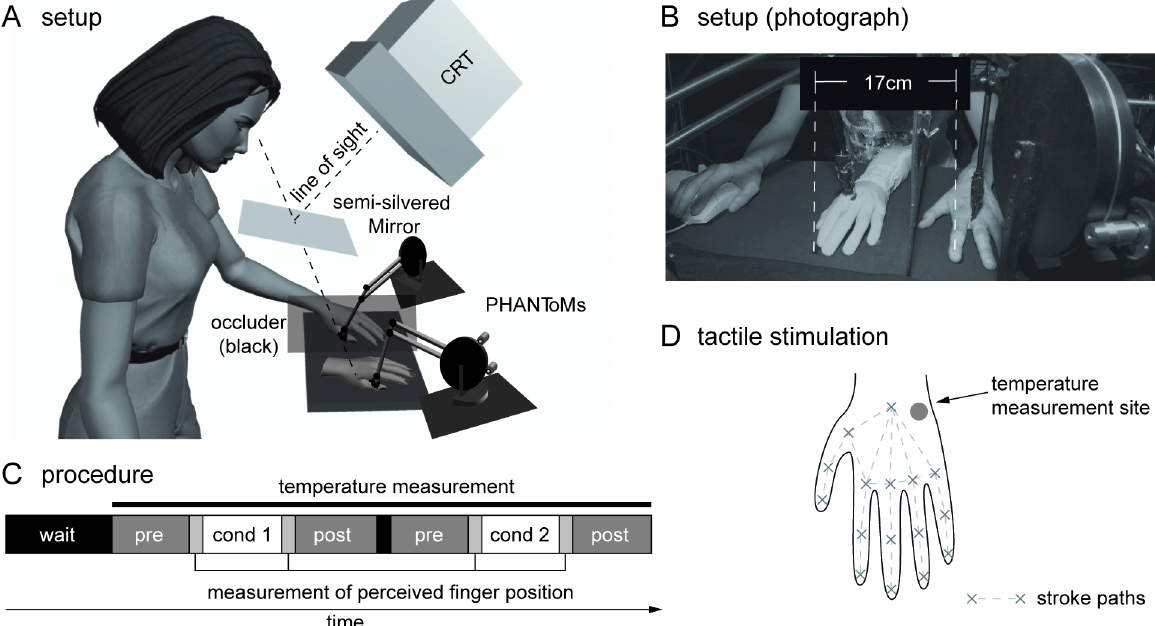
Fig 1. The RHI setup used in the study. Diagram(A) and photograph(B) of the setup. Two PHANToM TM force-feedback devices with paintbrushendings stroke the participant’soccludedhandand the visiblerubber hand. For testing proprioceptive drift, a probe dot is projectedinto the visual field using the CRT monitor and a semi-silvered mirror. The participant in (B) has given written informed consent, as outlined in the PLOS consent form, to publication of their photograph.C: The experimental procedure. D: Calibration points and lines along which strokes were applied,as well as temperature measurement location.Image for Fig 1A is courtesy of Rohde M, Di Luca M, Ernst MO (2011) The Rubber Hand Illusion: Feelingof Ownershipand Proprioceptive Drift Do Not Go Hand in Hand. PLoS ONE 6(6):